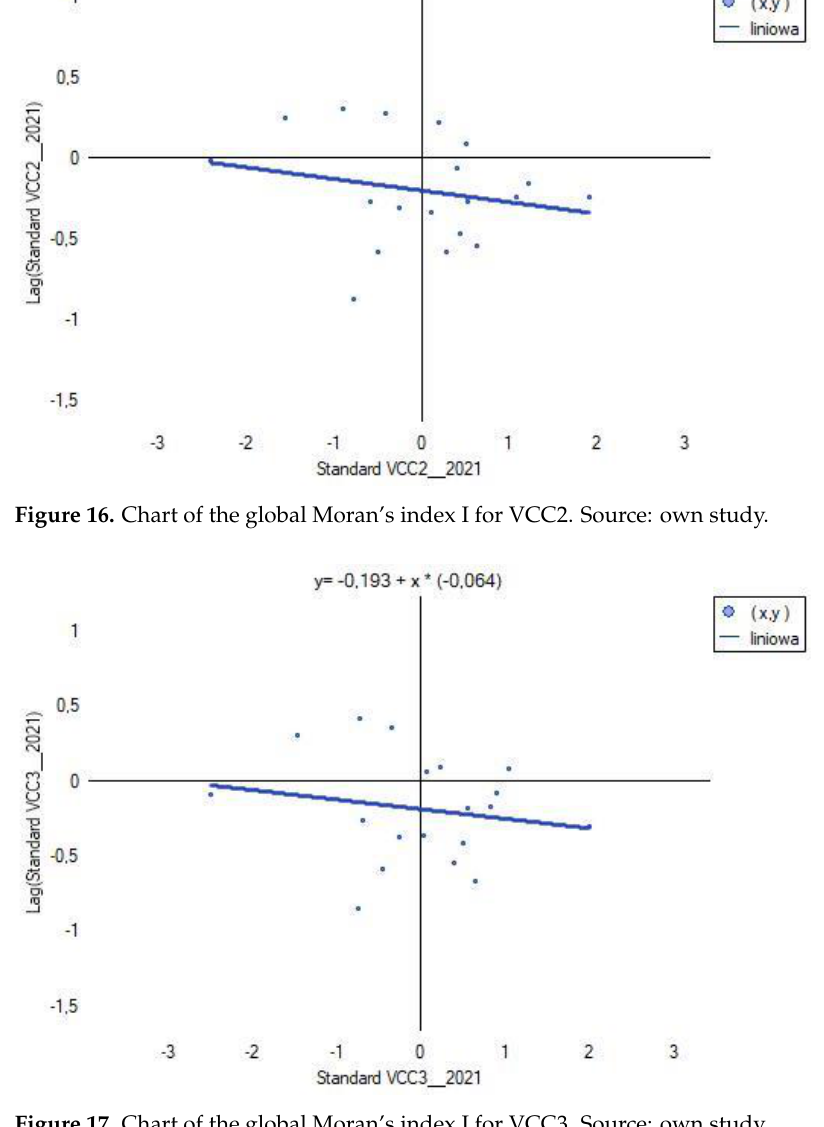
Figure 17. Chart of the global Moran’s index I for VCC3. Source : own study. Table 4. Global Moran’s I for X1, X2, X14, X15,